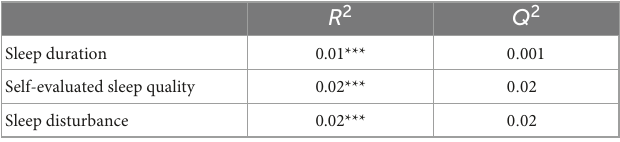
TABLE 3 Coefficient of determination ( R 2 ) and predictive relevance ( Q 2 ) of the model ( N = 24,541). R 2 Q